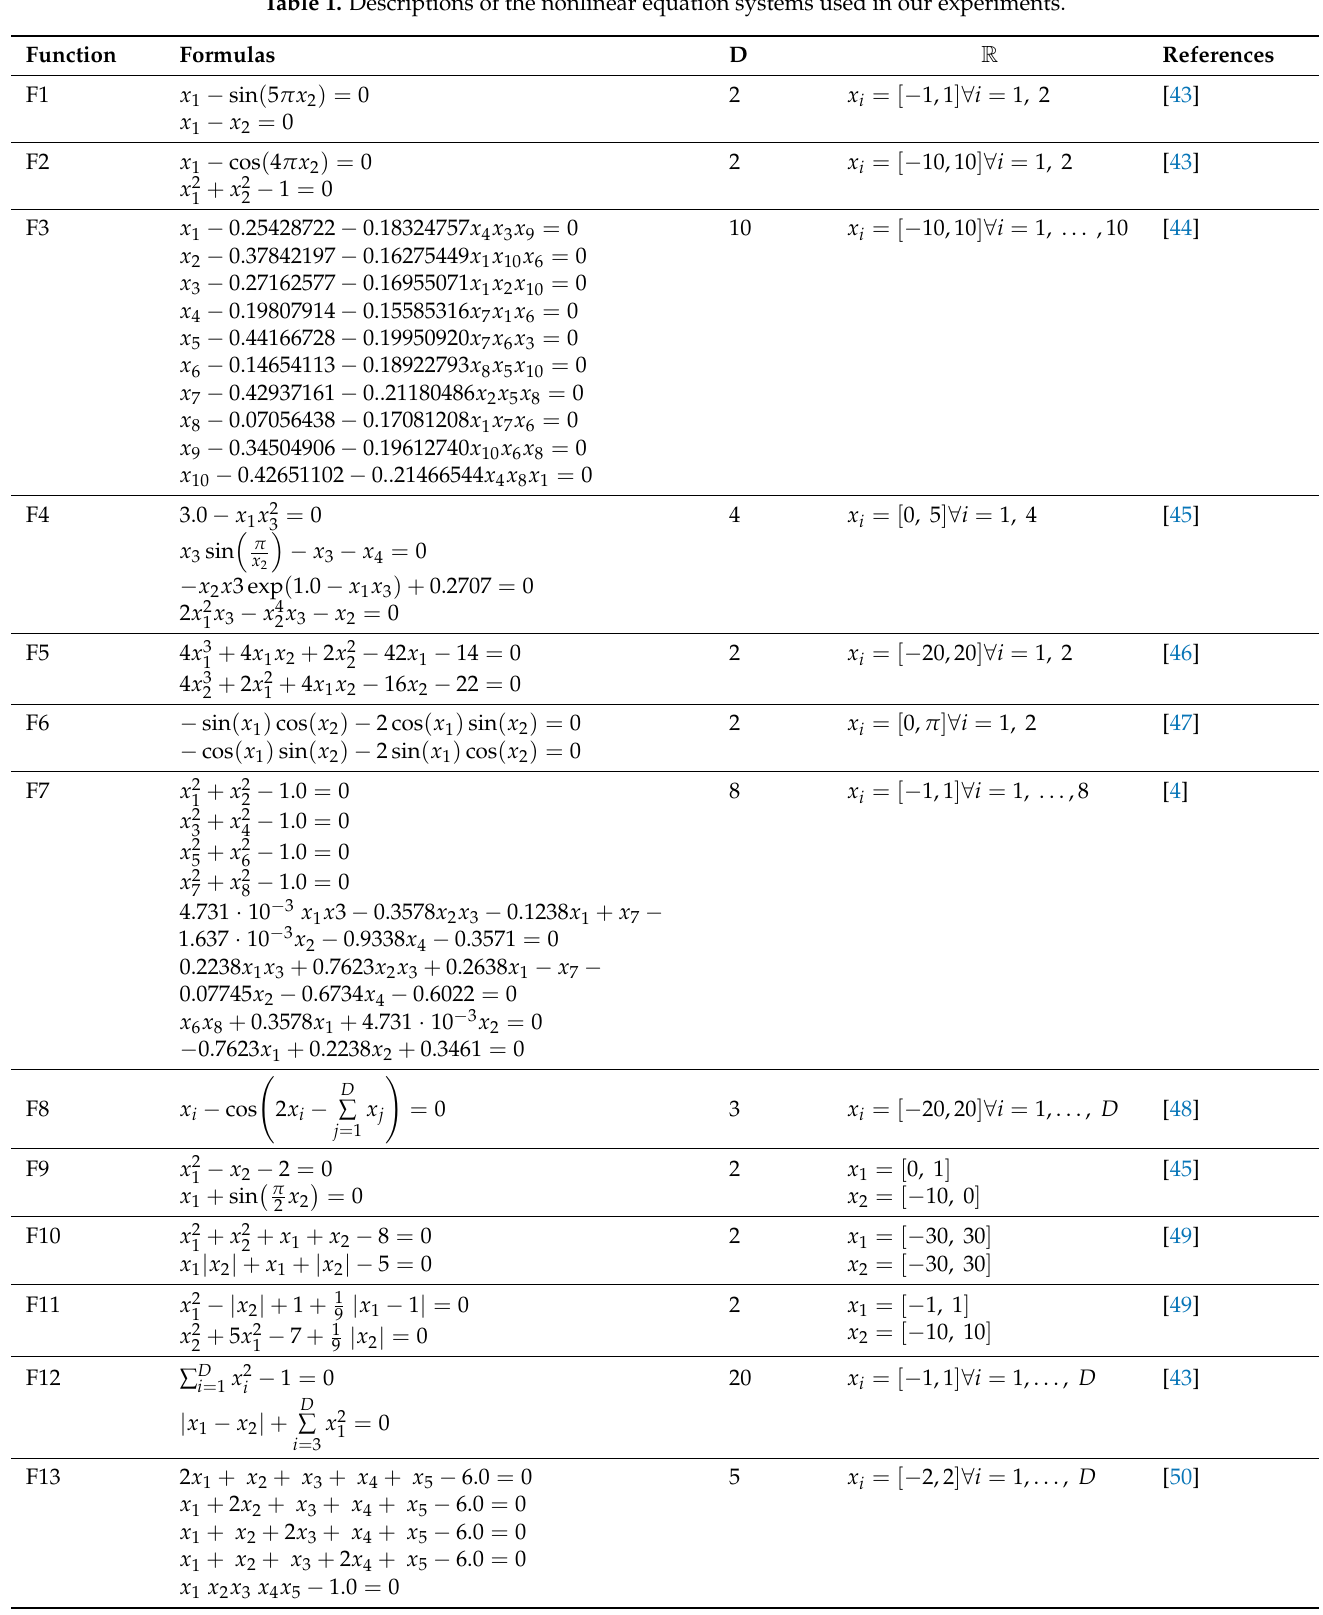
Table 1. Descriptions of the nonlinear equation systems used in our